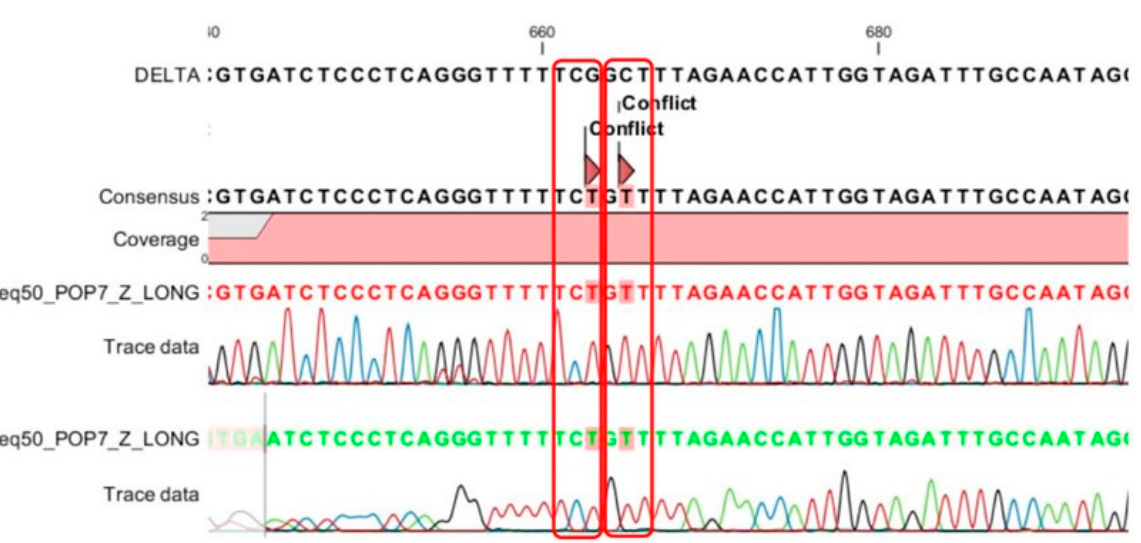
Figure 8. Sanger sequencing of the 7 patterns in the samples detects 2 mutations, A222V and (TCG)221(TCT), and because of these two mutations, mismatch happens between the 222A_tqPR (taqman probe) with the target sequence.